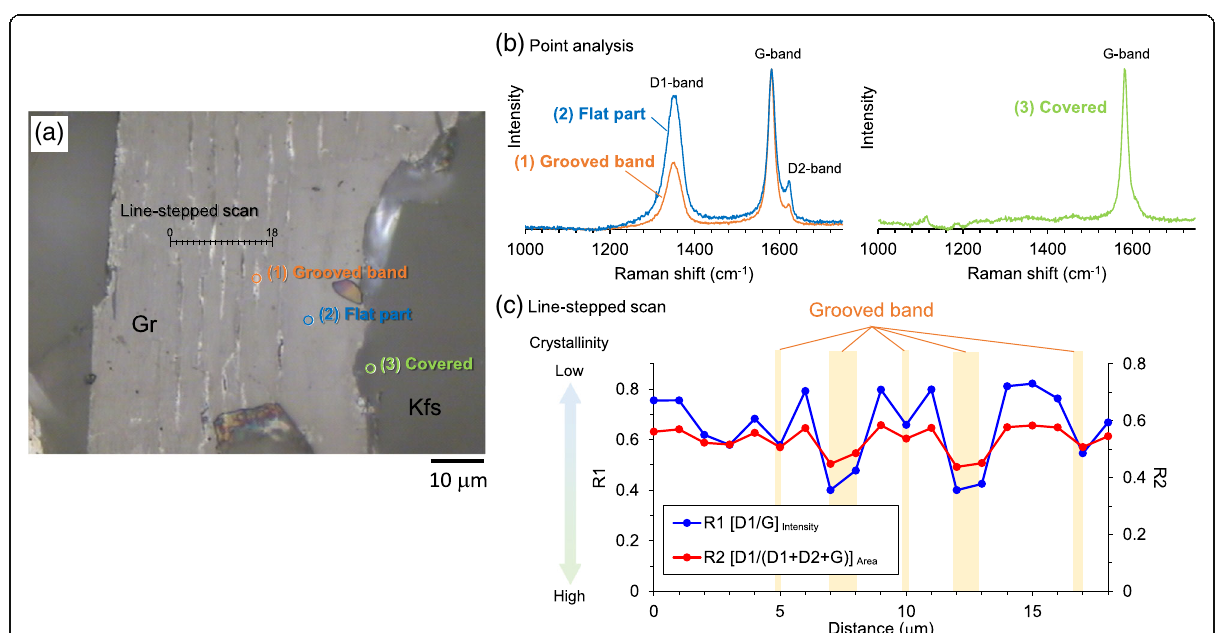
Fig. 4 Raman spectroscopic analysis of graphite. a Reflected light image of graphite showing the locations of point analyses and the line-stepped scans. b Raman spectra of point analyses of graphite for (1) the grooved band, (2) the flat part, and (3) the covered part. c Line-stepped scan of the graphite surface. The blue data indicate the value of R1 and the red data indicate the R2 values. The yellow shading indicates the locations of grooved bands